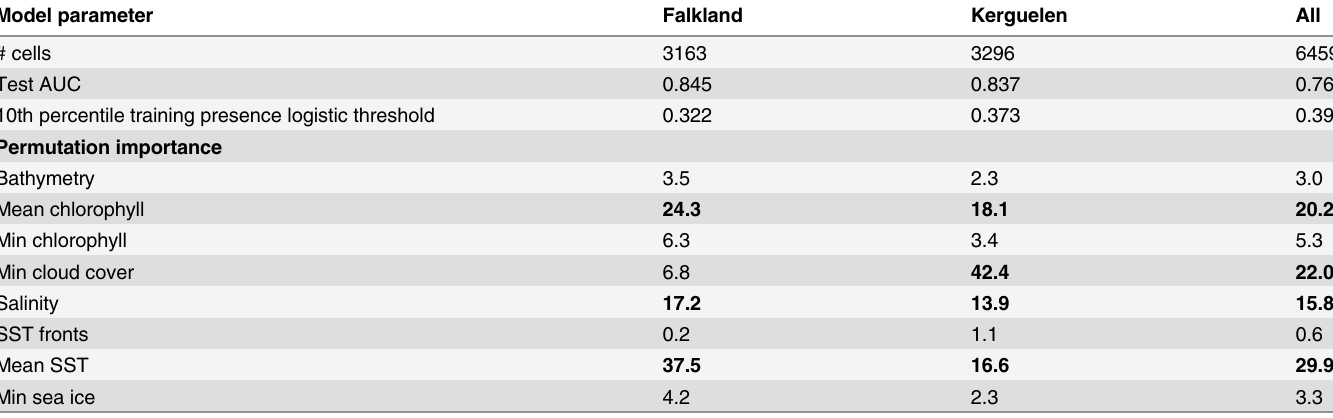
Table 3. Estimates of model fit and relative contributions of the environmental variables to the M AX E NT model, normalized to percentages (values over 10% are marked bold), for the non-breeding period for the two populations of thin-billed prions so separately, and combined.